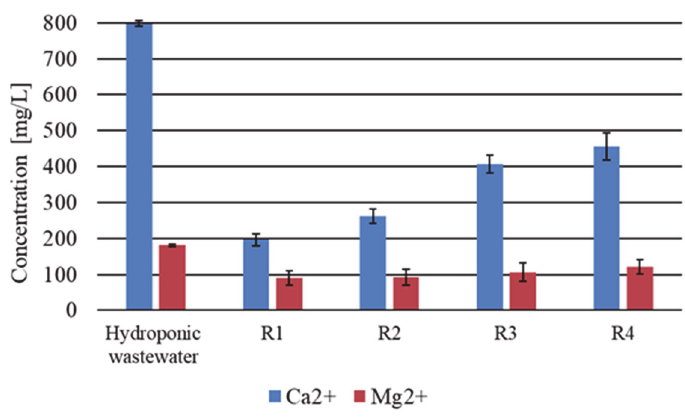
Figure 4. Ca 2+ and Mg 2+ concentration in hydroponic effluent and in treated wastewater.